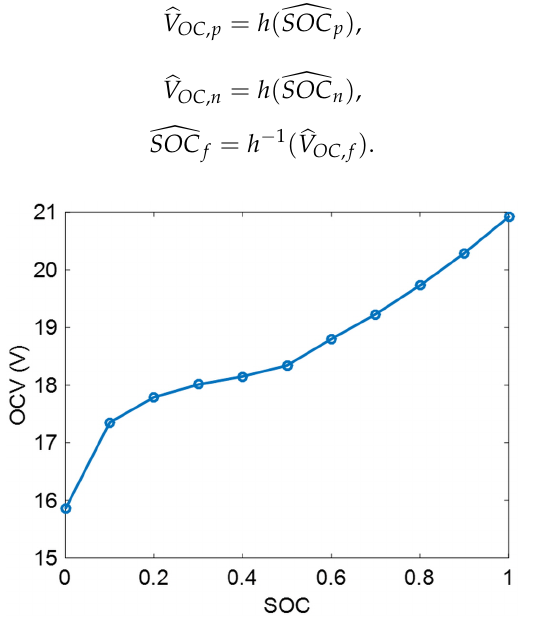
Figure 3. Relationship between open circuit voltage (OCV) and state of charge (SOC) of the normal battery